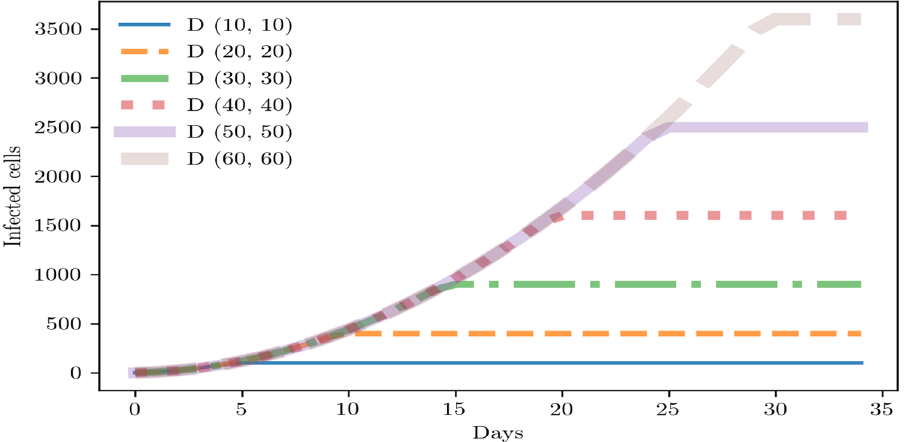
Figure 1. Virus transmission without any intervention in different array sizes. D ( ) represents the dimension of the array. The starting point of lines with zero slopes describes the number of days in which all cells were